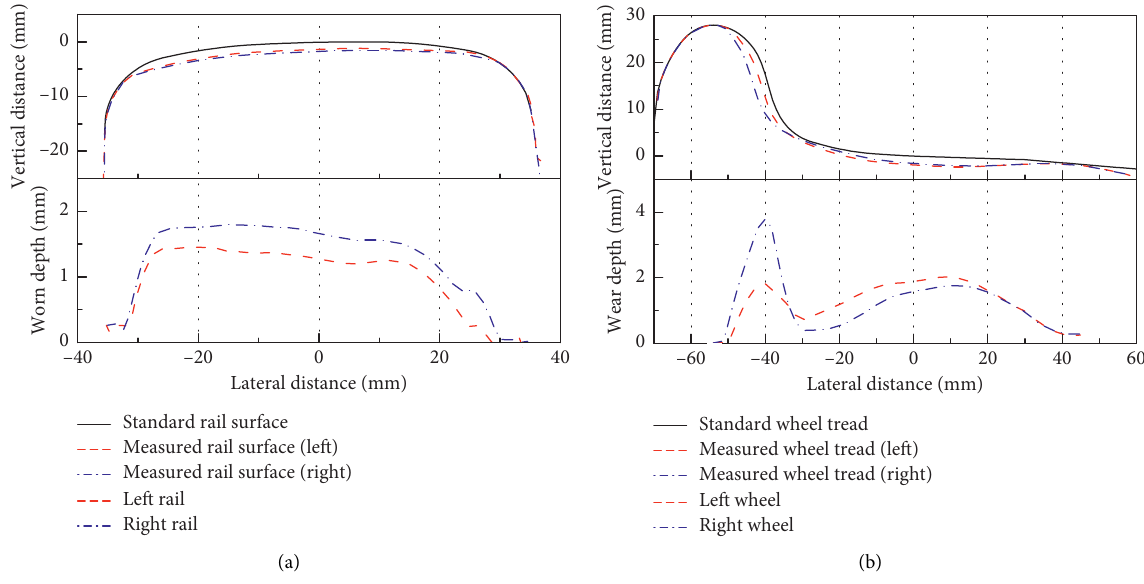
Figure 7: Measured surface and wear depth about rail and wheel. (a) Rail surface at swaying position. (b) Wheel tread about swaying vehicle.